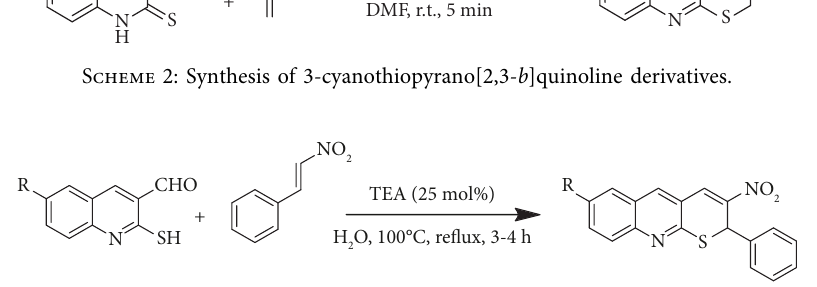
Scheme 3: Synthesis of 3-nitrothiopyrano[2,3- b ]quinoline